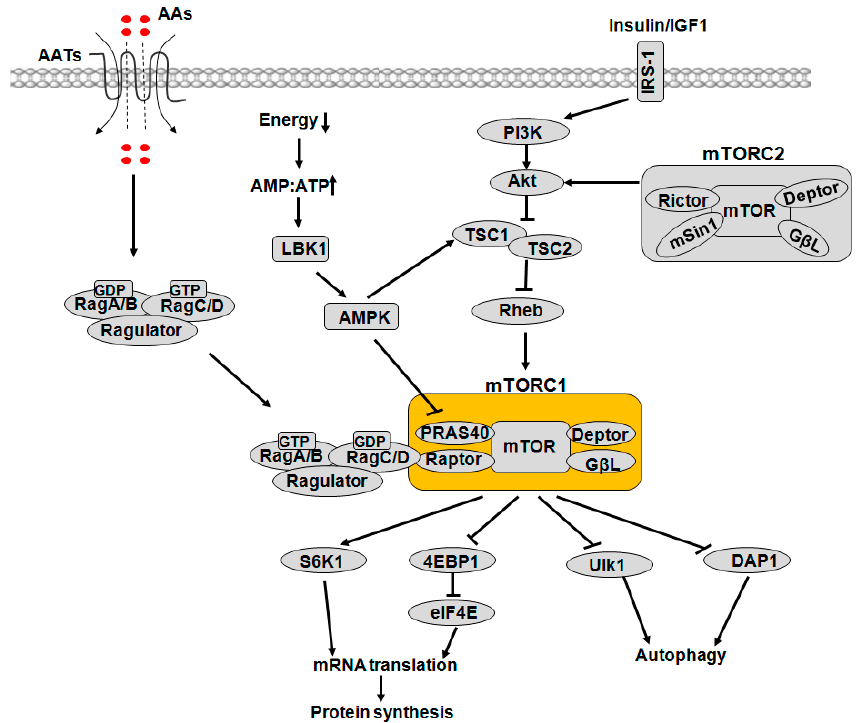
Figure 1. Model of mTOR signaling network in mammalian cells. It consists of two functionally different complexes known as mTORC1 and mTORC2. The mTORC1 pathway integrates inputs from at least three major cues, namely AAs, growth factors (such as IGF1 and insulin) and energy status, to regulate many major processes, including protein synthesis and autophagy. mTORC1 signaling is highly sensitive to AAs, which can be transported into cells through plasma membrane AATs, and then exert their regulatory roles. AA-dependent activation of mTORC1 requires small Rag GTPases. There are four Rag proteins that work in heterodimers. Rag A or B binds to Rag C or D. Upon growth factor stimulation, mTORC1 signaling is activated through the classical PI3K-PKB/Akt-TSC-Rheb pathway. Energy status is also sensed upstream of mTORC1. Low energy activates AMPK, which inhibits mTORC1 function by phosphorylating and activating TSC2 as well as phosphorylating Raptor. Arrows represent activation, whereas bars represent inhibition. mTOR: mammalian target of rapamycin; mTORC1: mTOR complex 1; IGF1: insulin-like growth factor 1; AAs: amino acids; AATs: AA transporters; PI3K: phosphatidylinositide 3-kinase; PKB/Akt: protein kinase B; TSC: tuberous sclerosis complex; Rheb: Ras homolog enriched in brain; Raptor: regulatory-associated protein of mTOR; AMPK: AMP-activated protein kinase.